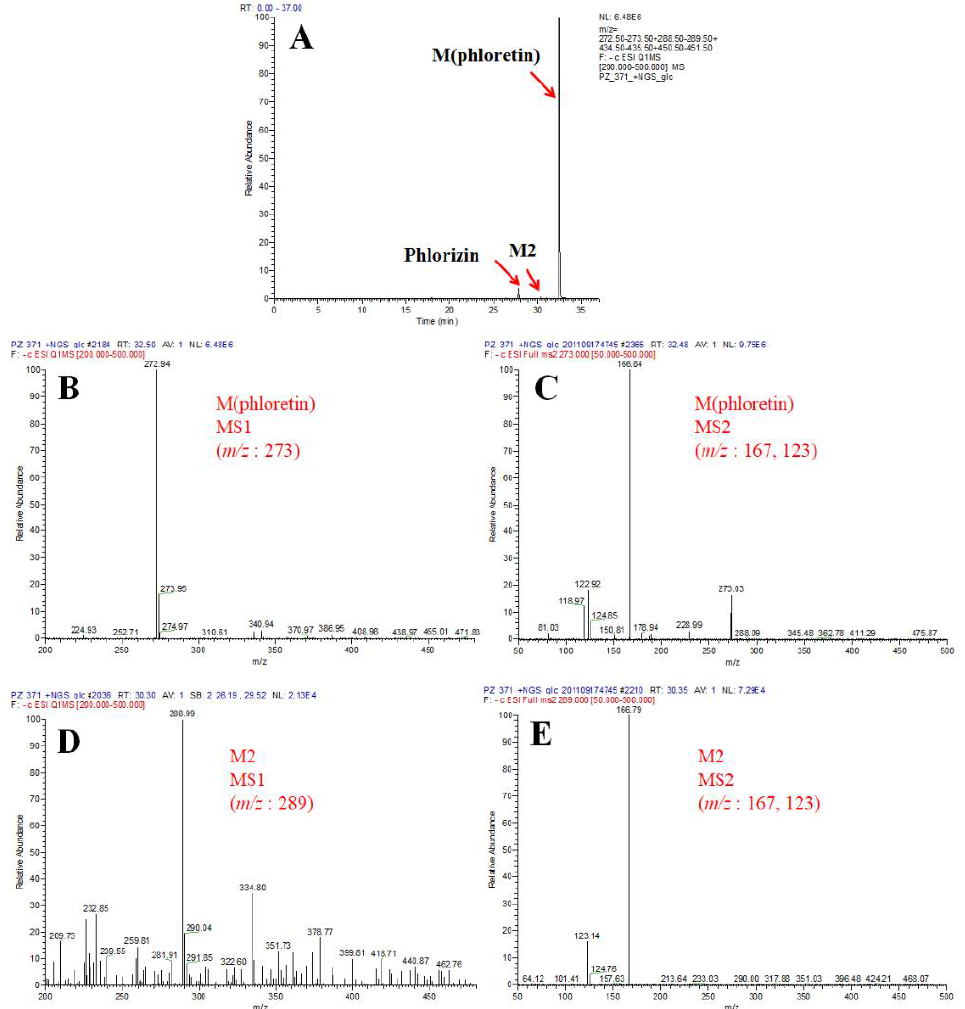
Figure 6. LC–MS/MS analysis of phlorizin and its products produced by treatment of CYP102A1 M371 and β-glucosidase. ( A ) TIC of phlorizin treated with M371 in the presence of NADPH, and subsequent treatment of β-glucosidase. ( B , C ) Each MS spectrum shows the protonated molecular ions ( m/z : 273) of phloretin ( B ) and its daughter ions (MS2) with additional fragmentation ( C ). ( D , E ) The MS spectra show the protonated molecular ions ( m/z : 289) of the product (M2) ( D ) and its daughter ions (MS2) with additional fragmentation ( E ).